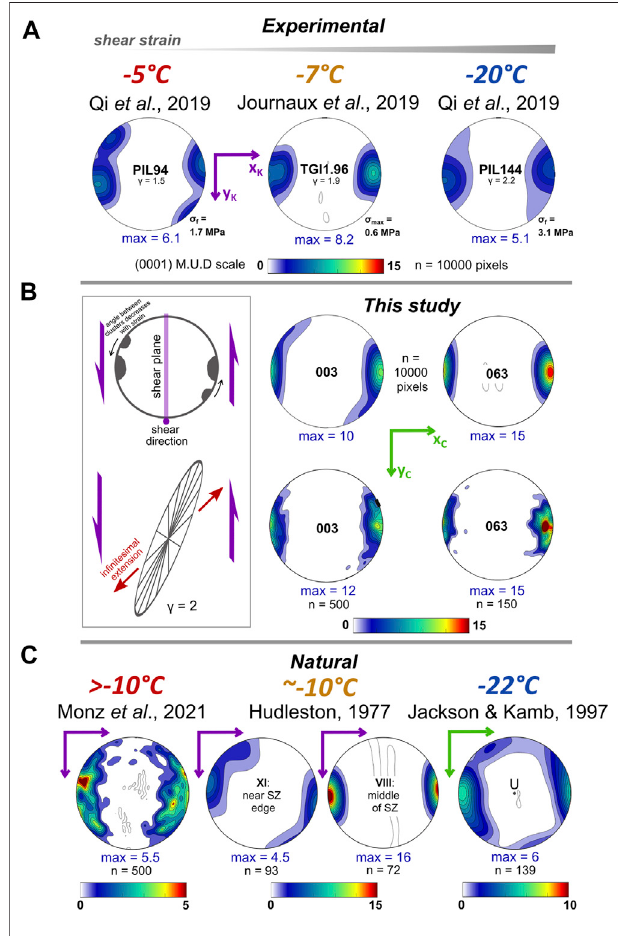
FIGURE 13 | Comparison of Priestley Glacier c -axis CPOs with (A) CPOs from experiments (Journaux et al., 2019; Qi et al., 2019) and (C) from natural glacial shear margins (Hudleston, 1977; Jackson and Kamb, 1997; Monz et al., 2021). For comparison with natural datasets, Priestley samples are also presented as one point-per-grain CPOs (B) . The inset schematic describes the geometry of a c -axis CPO for ice deformed under simple shear (see section 4.2 for details). A strain ellipse for a shear strain of 2 de fi nes an angle of in fi nitesimal extension 45 ° clockwise of the c -axis maximum, normal to shear plane. Shear strain is represented as γ , fi nal or maximum shear stress represented as σ f or σ max ,